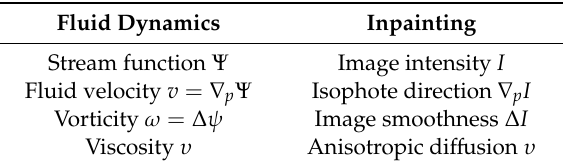
Table 2. Correspondence between the variables of an incompressible fluid flow problem and the Navier–Stokes inpainting